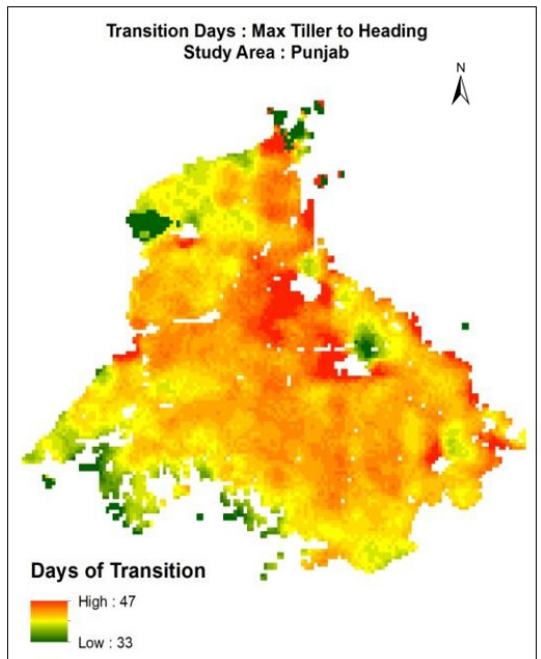
Figure 9: Transition to Heading of Rice crop in Punjab